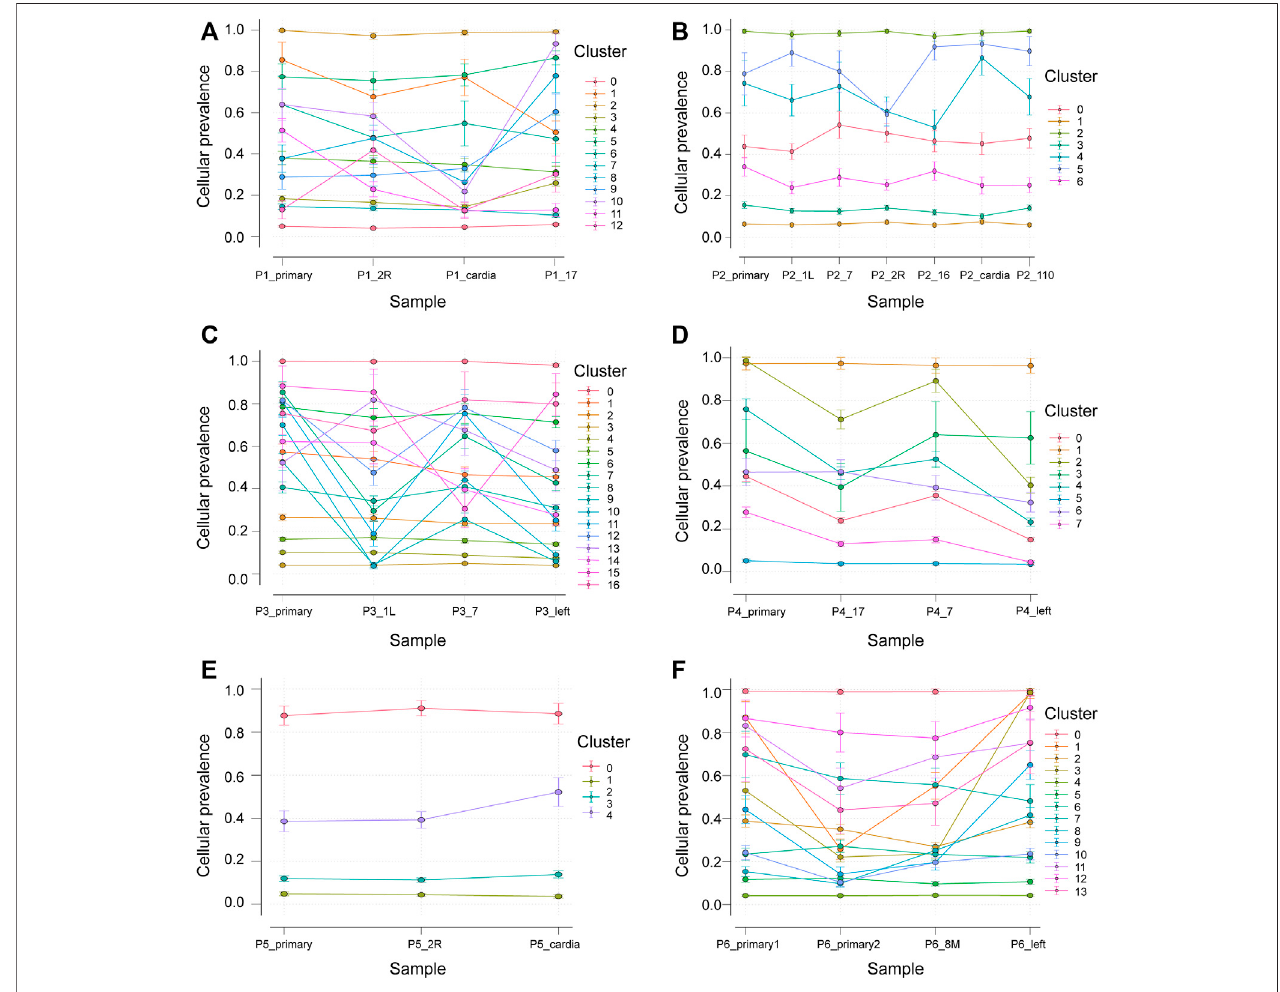
FIGURE 4 | Subclones of primary and metastatic LNs in all samples generated by using PyClone were composed. Each panel represents a patient, the x -axis represents not a time but a sample, and the y -axis represents the mean cell prevalence of variation in all clusters in each sample. (A – F) Patients 1 to 6.